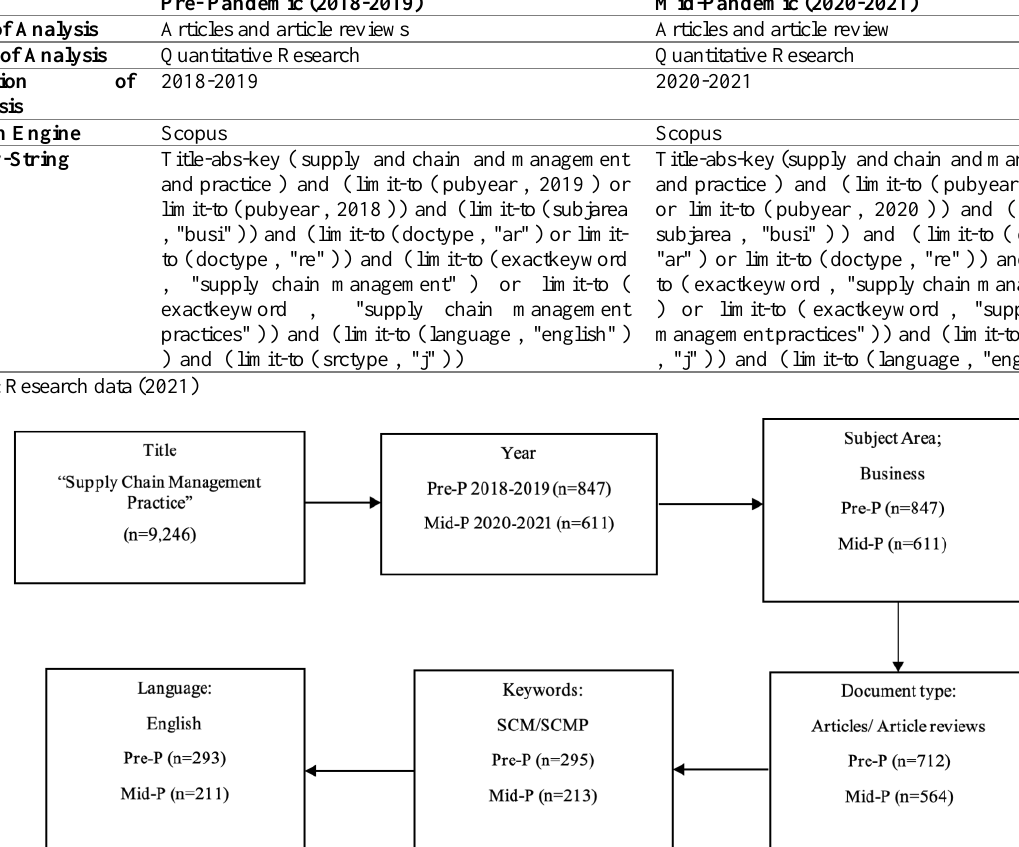
Figure 1: Methodological Steps; Source: Research data (2021)